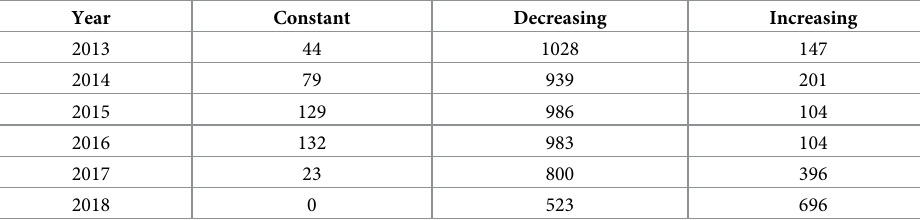
Table 2. Number of hospitals in different scale revenue